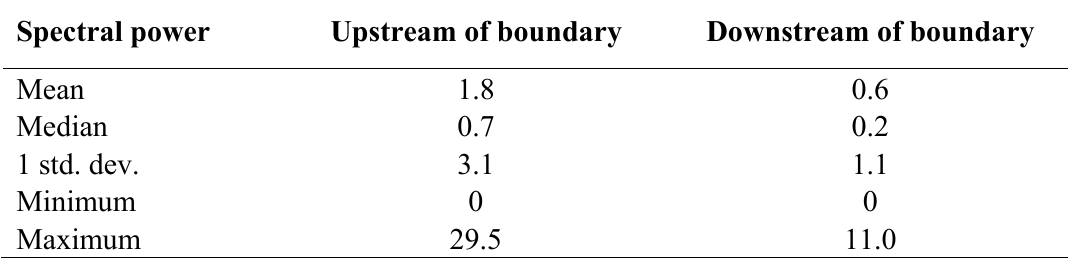
Table 4. Spectral power characteristics of thalweg profile, lower Bear Valley Creek, ID,